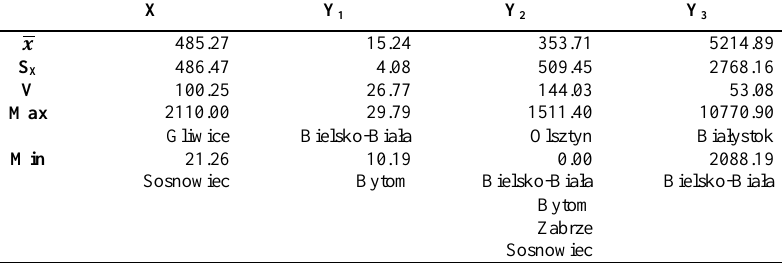
Table 2. Variables available for analysis